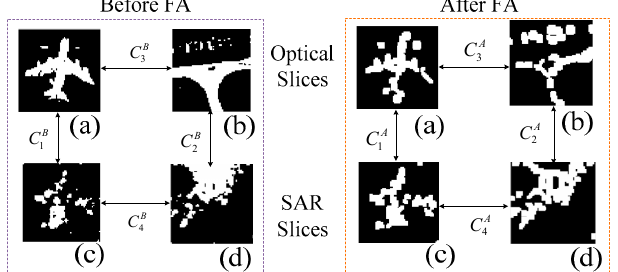
in SAR respectively. Among these, C1 is the correlation coefficient of the cross-source target; C2 is of